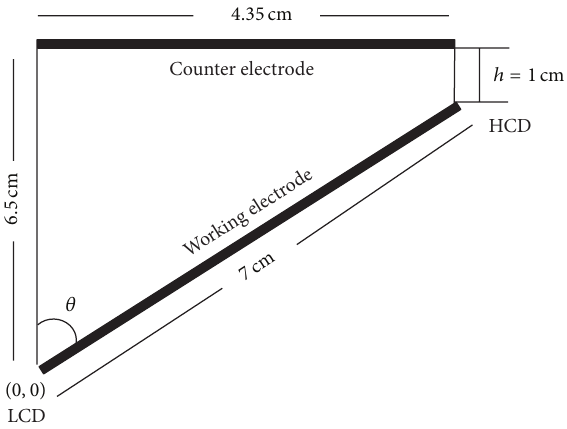
Figure 1: Schematic diagram of the modified Hull cell